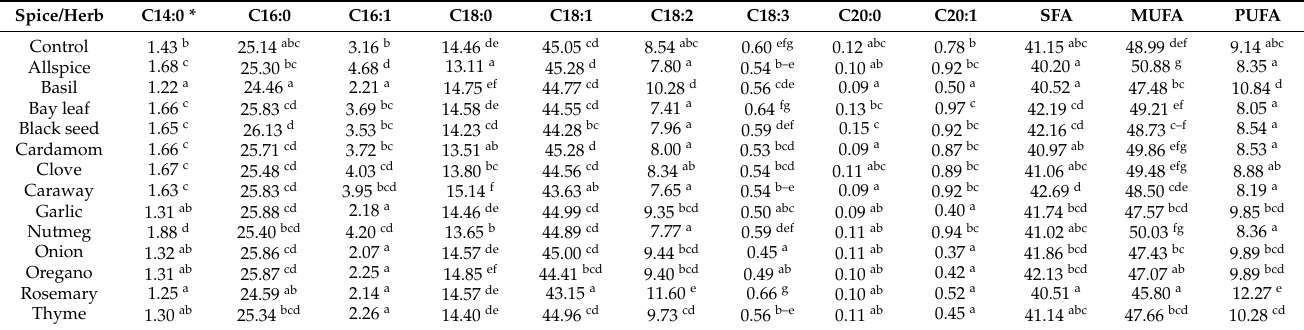
Table 2. Fatty acid composition (%) of raw pork neck during 13 days of storage at 4 ◦ C.